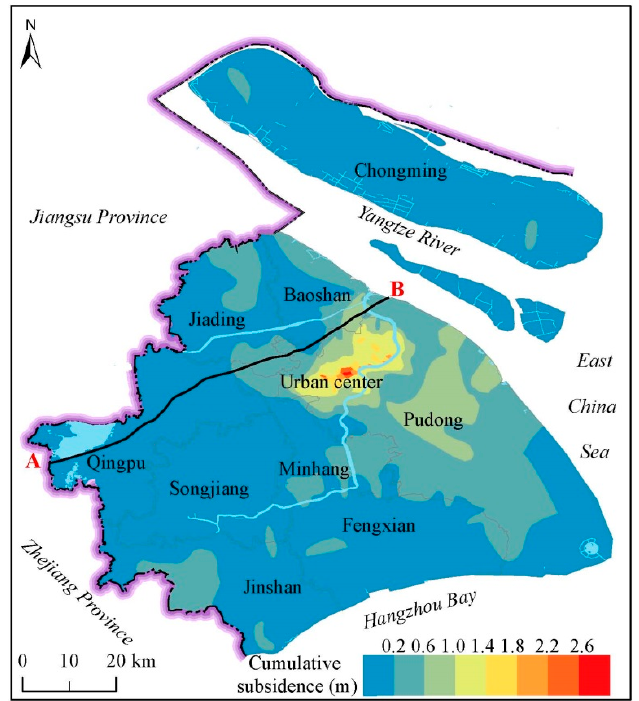
Figure 1. Overall land subsidence in Shanghai (from 1921 to 2016) (data from Reference [18]).